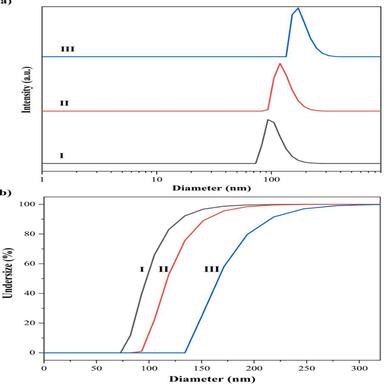
(a): Size distribution of Fe3O4 (I), Fe3O4/QSM (II), and Fe3O4/QSM/Ag (III) (b): cumulative size distribution of. Fe3O4 (I), Fe3O4/QSM (II), and Fe3O4/QSM/ Ag (III).